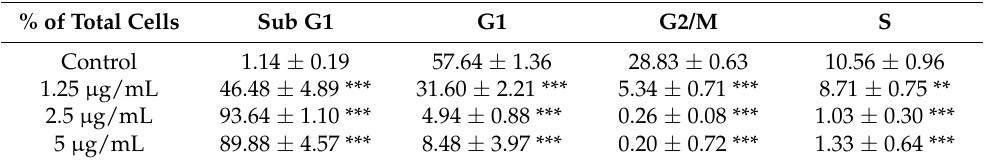
Table 2. Flow-cytometric analysis of the effects of tagitinin C on the Huh 7 cell cycle after 24 h of treatment. Huh 7 cells (8 × 10 5 cells/mL) treated with or without tagitinin C for 24 h were harvested and fixed with 1 mL of ice-cold 70% ethanol at 4 ◦ C for 2 h. The proportion of cell cycle phases was analyzed using fluorescence-activated cell sorting flow cytometry (BD FACSCalibur™ Flow Cytometer; BD Biosciences, San Jose, CA, USA). ** p < 0.01 vs. control, *** p < 0.001 vs. control. The groups were compared using the Student’s t